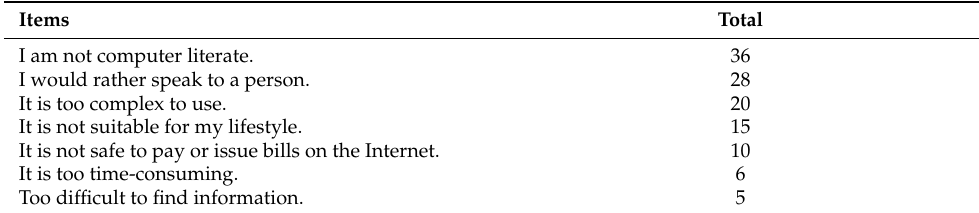
Table 3. Factors that affect the use of government